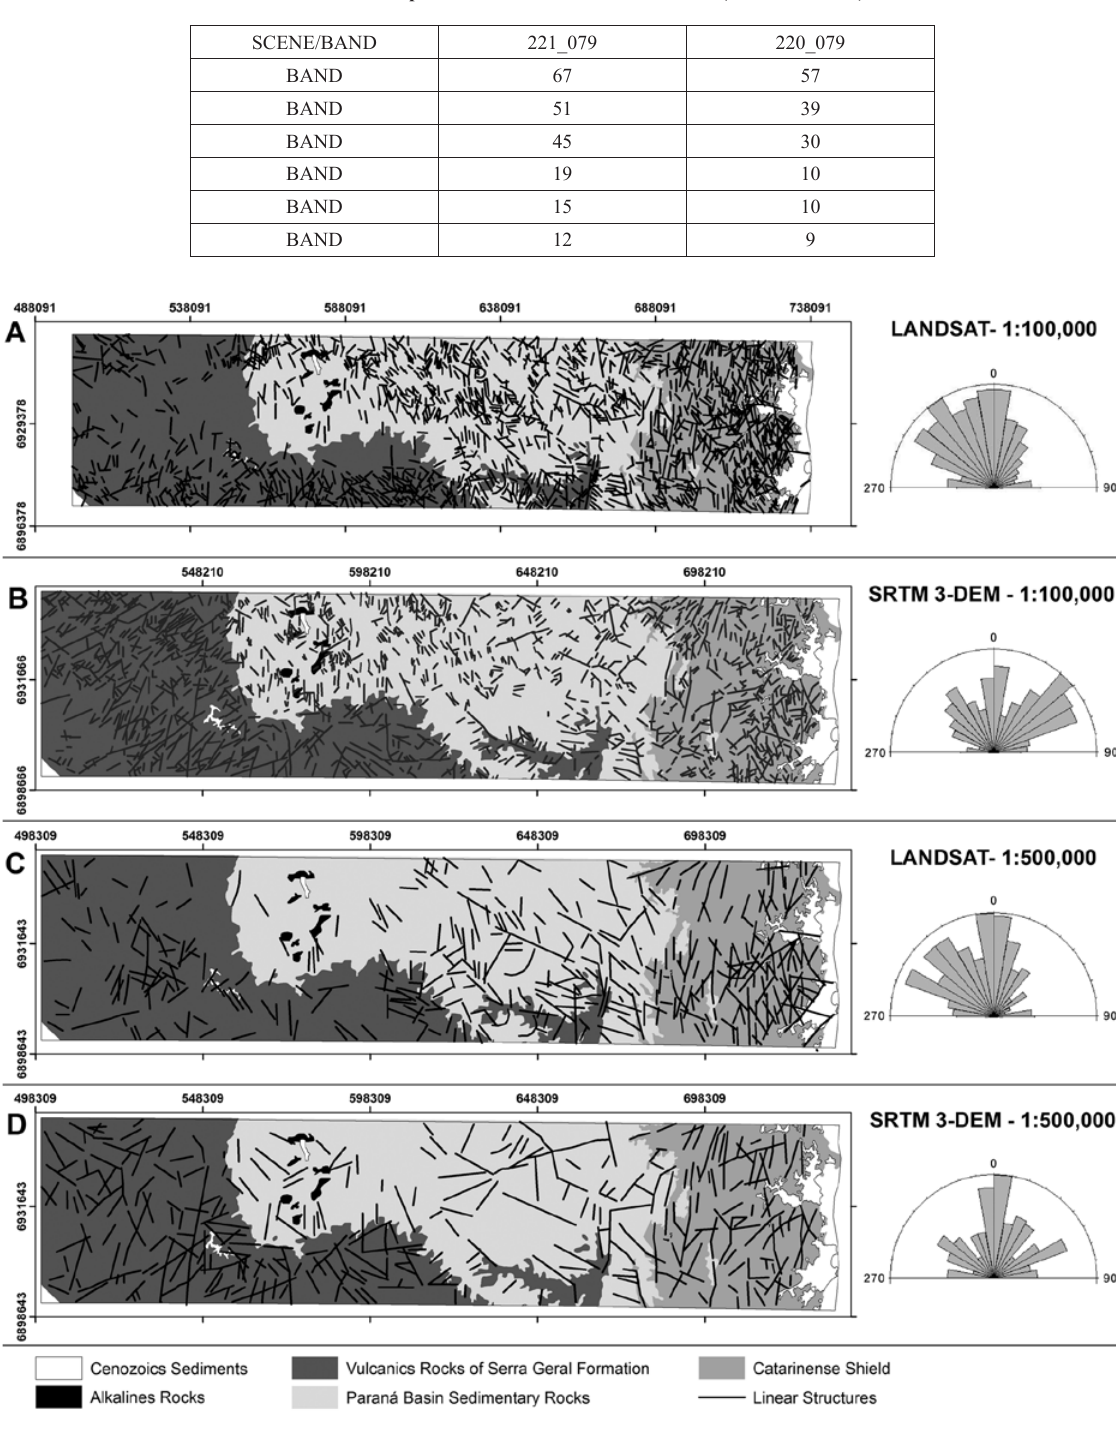
Figure 2 - Products obtained by visual interpretation: (A) LANDSAT at 1:100,000 scale; (B) SRTM at 1:100,000 scale; (C) LANDSAT at 1:500,000 scale and (D) SRTM at 1:500,000 scale and their respective rose diagram for total